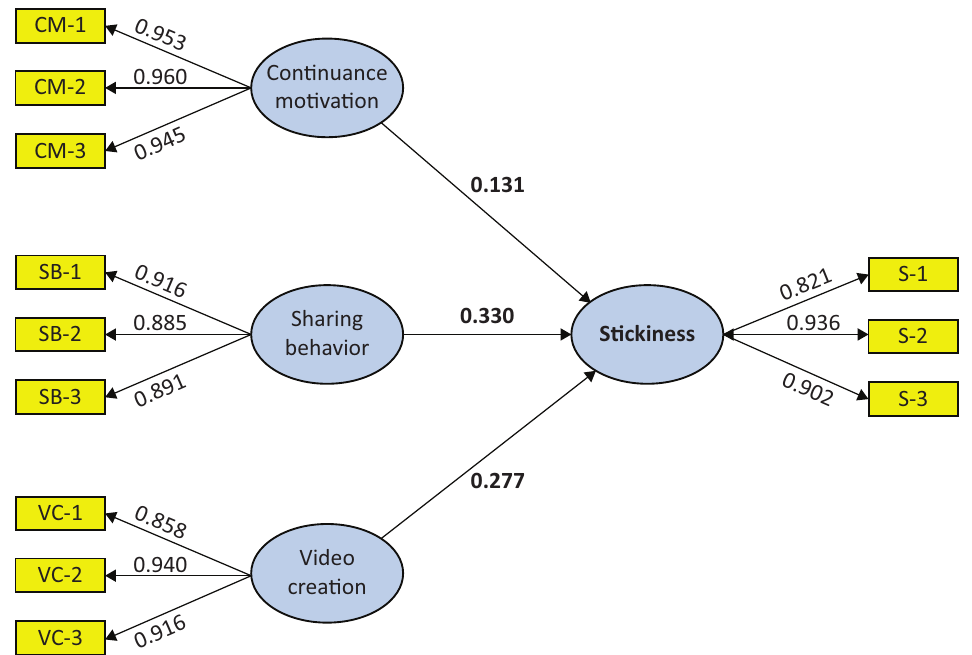
Figure 3. Model result for